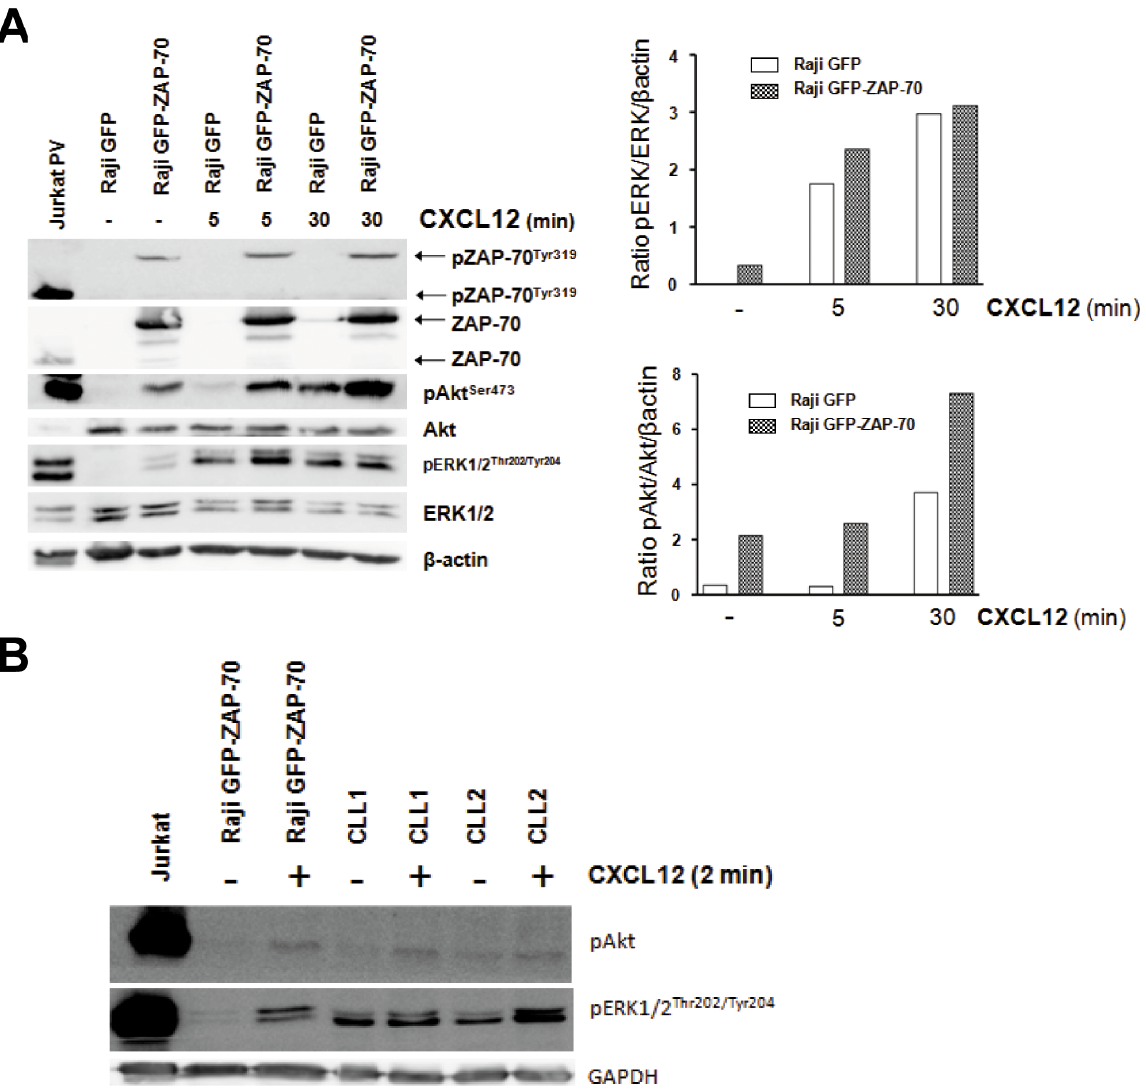
Figure 4. CXCR4 signaling is enhanced in B-cells expressing ZAP-70. (A) Raji transfectants were stimulated with 100 ng/mL of CXCL12 for 5 or 30 minutes and protein phosphorylation was analyzed by western blotting. Enhanced phosphorylation of ZAP-70, Akt and ERK1/2 was observed in the Raji GFP-ZAP-70 cells stimulated with CXCL12. The figure shows a representative example of 3 independent experiments. (B) Raji transfectants and primary CLL cells were stimulated with 100 ng/mL of CXCL12 for 2 minutes and protein phosphorylation was analyzed by western blotting. Similar activation of Akt and ERK1/2 proteins was observed between Raji and primary CLL cells. Jurkat cells treated with pervanadate (PV) were used as positive controls. Note that ZAP-70-GFP fusion protein expressed by Raji GFP-ZAP-70 cells is 97